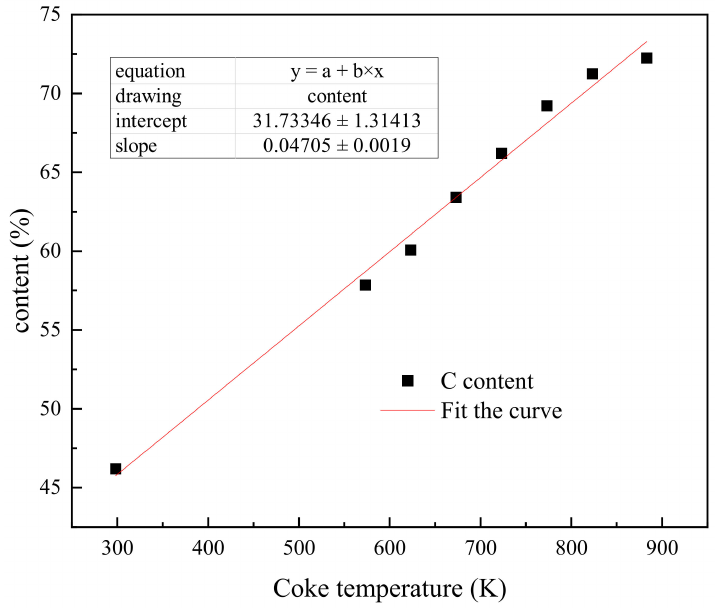
Figure 5. Fitted curve of semi-focused elemental C content versus